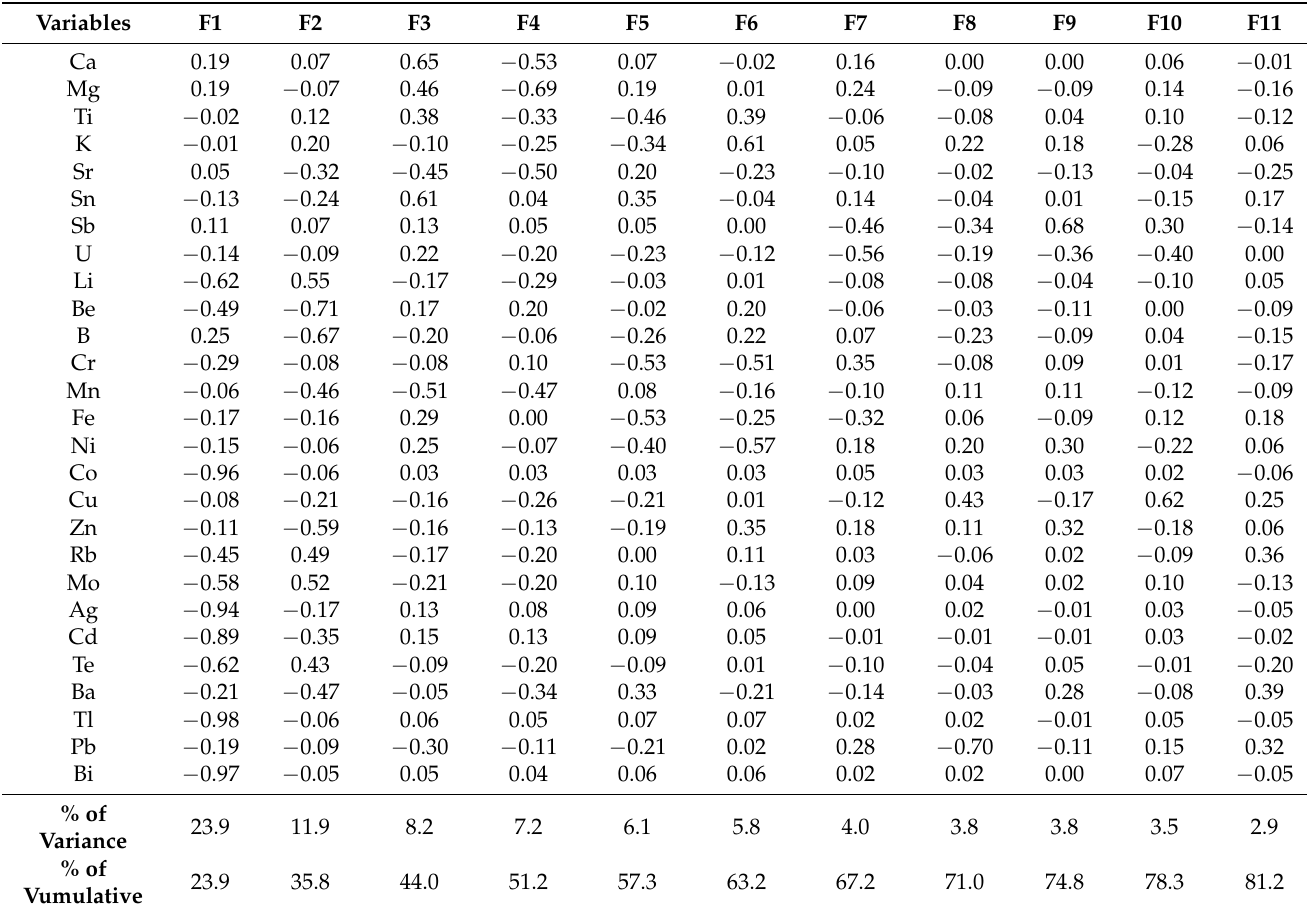
Table 8. Information on factor